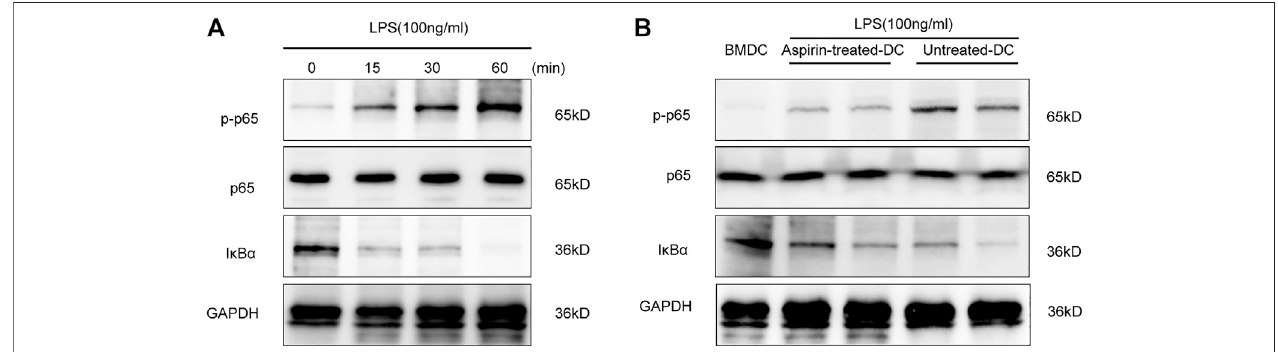
FIGURE5| AspirinregulatesthematurationofDCsthroughtheNF- κ Bsignalingpathway.Bonemarrow – deriveddendriticcellsweregeneratedfromB6bonemarrowcells with 2 mM aspirin added to the medium, and the DMSO was added only as the untreated control. DCs were collected from each group on the seventh day and administered 100 ng/ml LPS stimulation. (A) Western blotting was performed to detect the phosphorylation level of p65 and the degradation level of I κ B α of BMDCs under LPS stimulation; GAPDH was used as the internal reference. (B) The phosphorylation level of p65 and the degradation level of I κ B α in aspirin-treated DCs and untreated DCs under LPS stimulation. GAPDH was used as the internal reference. Data represents four independent experiments. GAPDH, glyceraldehyde-3-phosphate dehydrogenase.